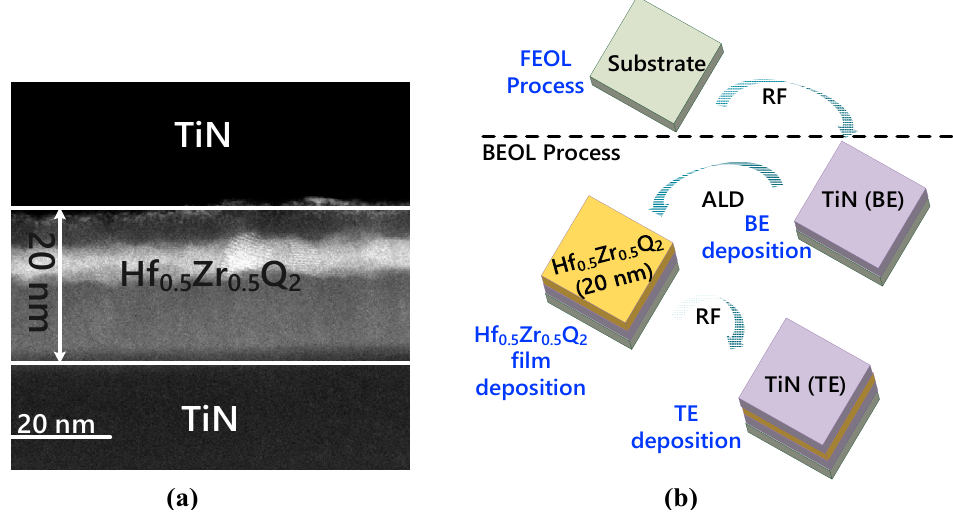
Figure 13. ( a ) Cross-sectional TEM images of a 20 nm thick HfO2 ferroelectric capacitor. ( b ) Fabrication process flow of a Hf 0.5 Zr 0.5 O 2 ferroelectric capacitor.